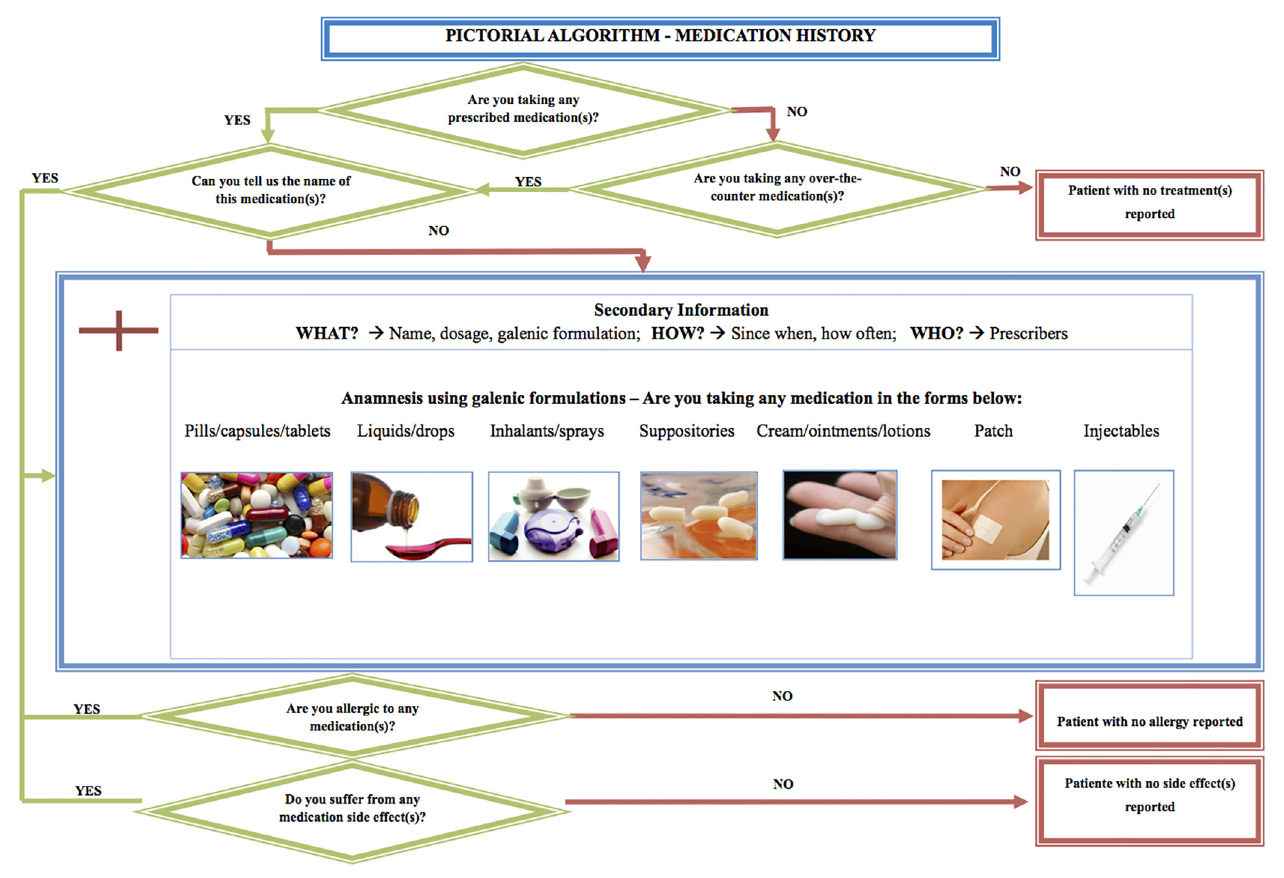
Fig 2. Patient inclusion Flow